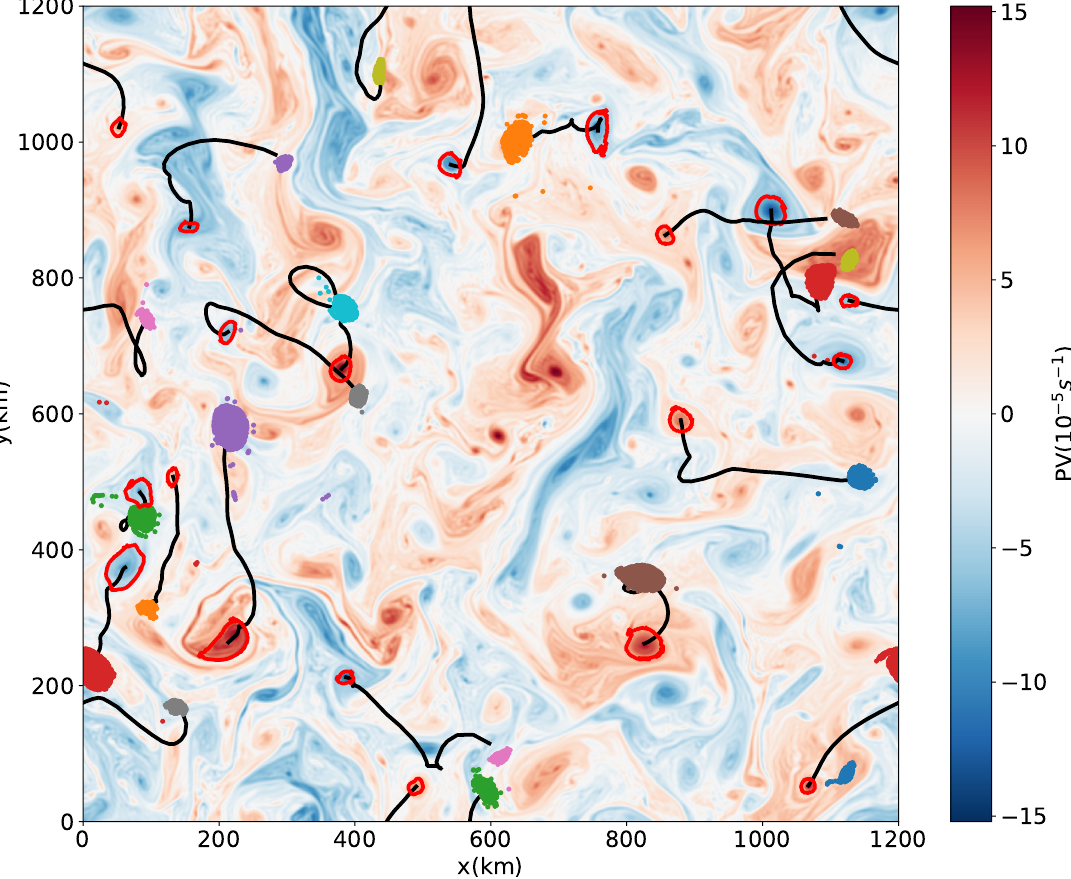
Figure 3. An example set of 30-day eddies from the weak friction case. The background field is the potential vorticity (PV) anomaly at the initial time, red curves give the boundaries of the coherent eddies at the initial time, black lines are the trajectories of eddy centers, and colored dots are the positions after 30 days of particles initially inside the